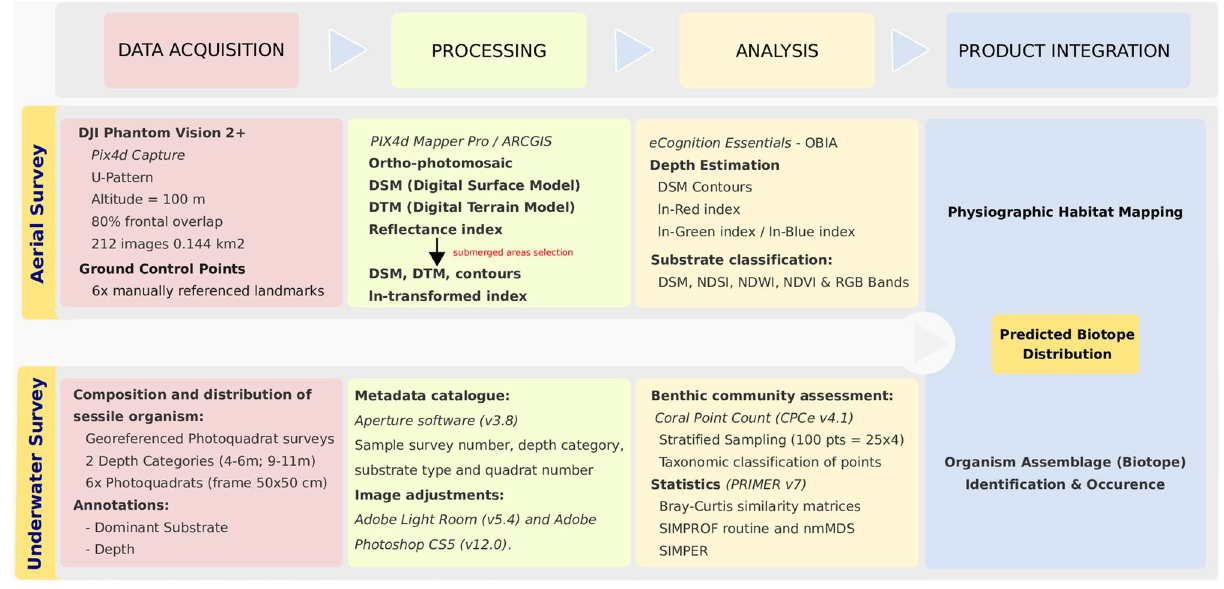
Figure 7. Workflow blueprint for implementing a coastal habitat mapping novel workflow integrating aerial RPAS based survey and underwater photo-based benthos surveys to identify and predict biotope